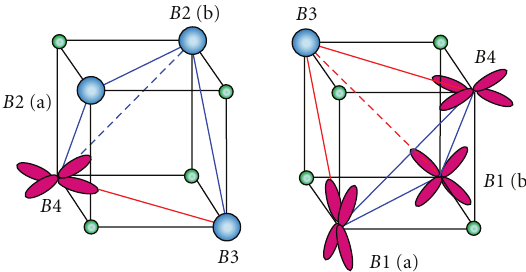
Figure 12: Sketch of the spatial arrangement of exchange interac- tion parameters between the octahedral Fe B sites [155]. Orbitals approximate the occupied 3 d minority orbitals of Fe 2+ cations are shown by large (blue) spheres. Oxygen atoms are shown by small (green) spheres. Ferromagnetic couplings between Fe B cations are shown by the thick (red) lines, whereas antiferromag- netic exchanges depicted by the thin (blue)